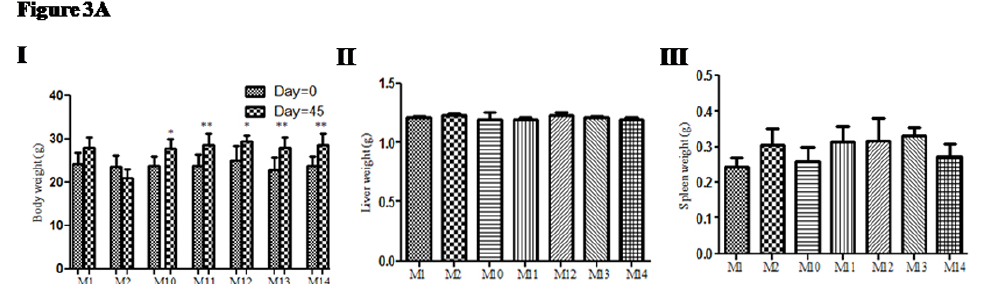
Fig. 3A. Adjunct therapy of recombinant cytokines (IL-17A and IFN- γ ) along with sub-optimal dose of AmpB, influence in significant improvement in body weight but not change in organ weight: (I) Change in body weight (II) Change in liver weight (III) Change in spleen